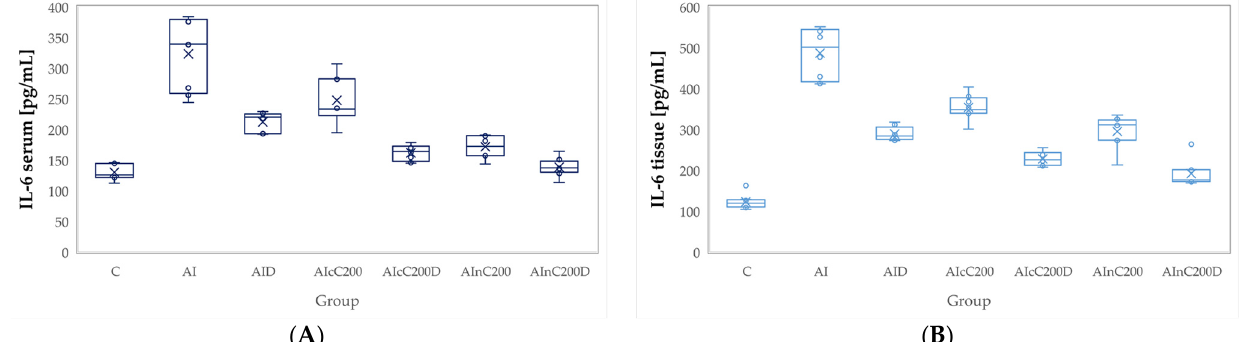
Figure 5. Variation by groups of IL-6 (Interleukin 6): ( A ) in the plasma ( B ) in the tissue. C—control; AI—Acute inflammation; D—Diclofenac; cC—conventional curcumin solution (200 mg/kg b.w.); nC—curcumin nanoparticles solution (200 mg/kg b.w.).